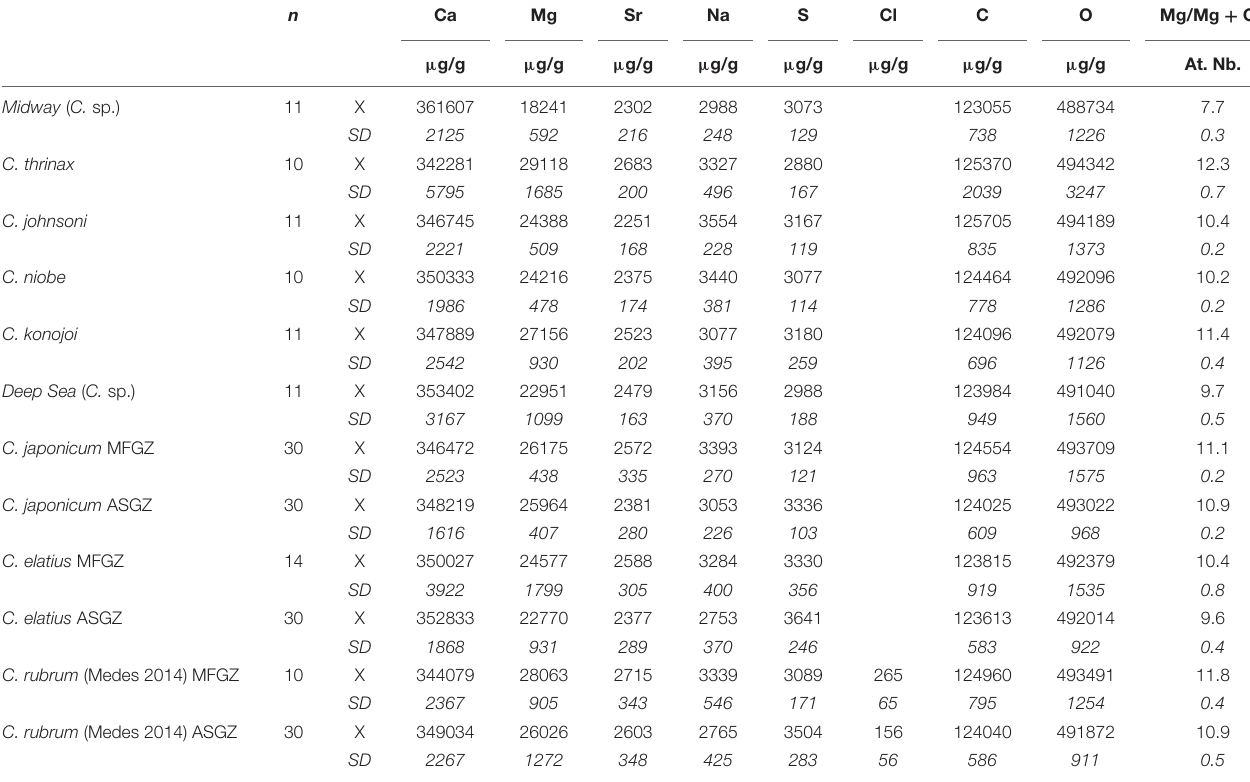
TABLE 1 | Electron microprobe analyses of Corallium skeletons.